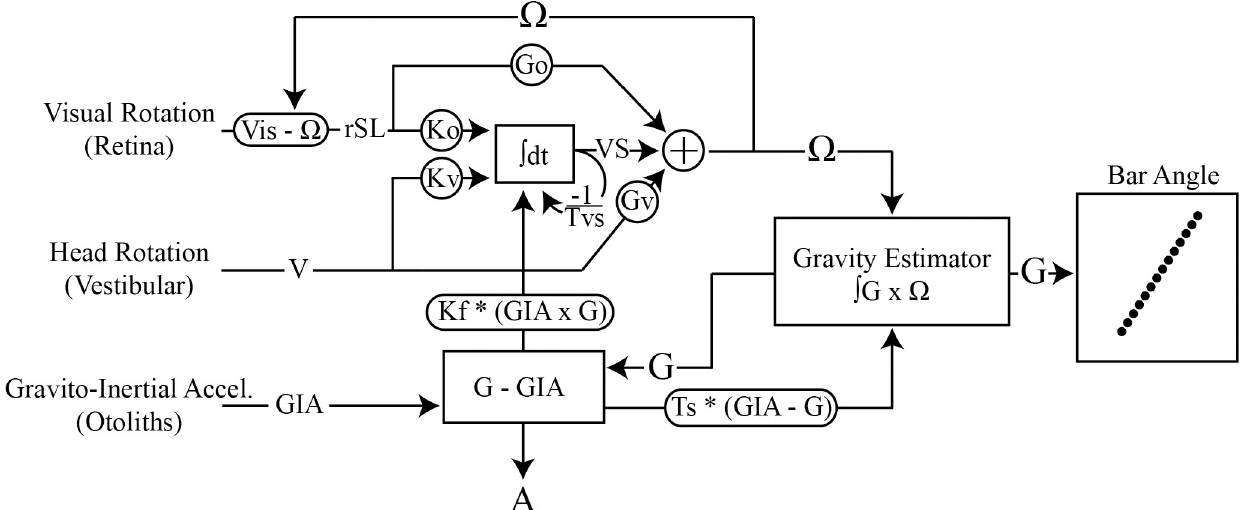
Fig 2. Schematic of the mechanistic model describing the transformation of visual and vestibular motion to a change in bar angle. Visual motion (Vis) is encoded as retinal slip (rSL), the difference between the internal estimate of the head’s velocity and scenes velocity. The retinal slip information is multiplied by gain Ko (0.11 � {1-percent noise}) and integrated overtime with vestibular signals (V) multiplied by gain Kv (0.2). The integration process is leaky with time constant Tvs (15) and is influenced by rotation feedback derived from the cross product of the Gravitoinertial acceleration signal (GIA) and the inferred orientation of gravity (G) multiplied by gain Kf (0.0). This integration process has been broadly described as velocity storage process. The output of the velocity storage is then summed with the rSL, multiplied by gain Go (0.16 � {1-percent noise}), and V, multiplied by gain Gv (0.43), to infer the angular velocity of the head ( O ). The cross-product of the inferred angular velocity of the head and the inferred gravity vector is then integrated to estimate the gravitational vector. This cross-product ensures that only rotations orthogonal to gravity are integrated. The difference between GIA and G is then used to estimate linear acceleration of the head (A) and acts as a negative feedback loop, that models the somatogravic effect, acting to pull G back into alignment with GIA (with gain factor Ts {0.74 }). For a more detailed description of this model see Laurens and Angelaki 2011 and Laurens et al., 2013a.